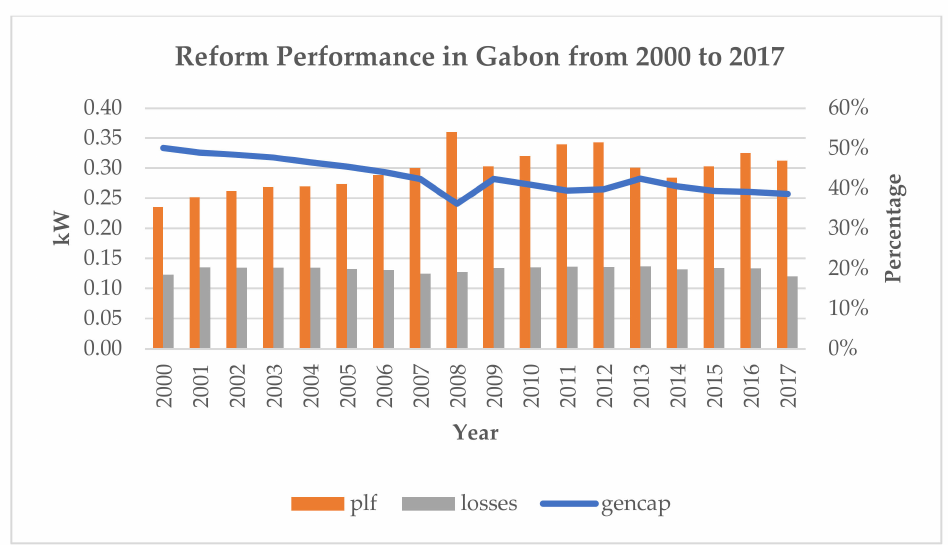
Figure 3. Evolution of plant load factor (in percentage), technical network losses (in percentage) and installed generation capacity per capita (in kilowatt) in